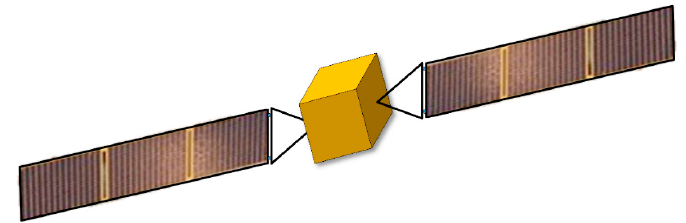
Figure 1. Diagram of the LSFS.